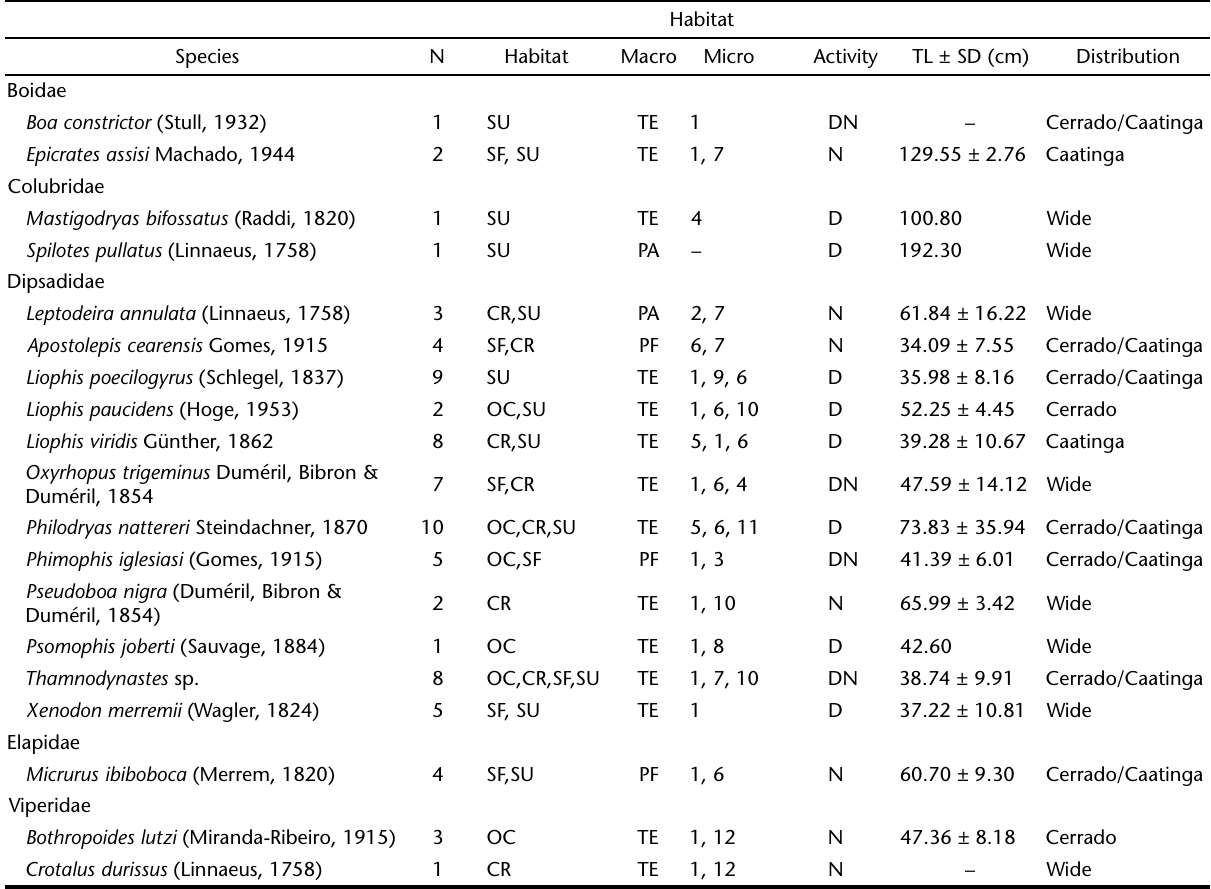
Table I. Ecological attributes of the snake community in the locality of Castelo do Piauí, state of Piauí, Brazil. Subtitles: Habitat (phytophysiognomies): (CR) low altitude Cerrado Rupestre, (OC) open Cerrado, (SF) secondary forest of typical Cerrado, (SU) Surroundings of study area. Macrohabitat: (PF) primary or exclusively fossorial, (PA) primary or exclusively arboreal; CT = criptozoic and terrestrial. Microhabitat: (1) on the ground, (2) in the tree canopy, (3) buried in the ground, (4) over rocks, (5) under rocks, (6) under leaf litter, (7) over leaf litter, (8) on trunks in the understory, (9) on fallen logs, (10) in hollow trunks, (11) inside a termite hill, (12) over a termite hill. Activity: (D) diurnal, (N) nocturnal, (DN) diurnal/nocturnal, (TL) mean total length, (SD) standard deviation, (–) no